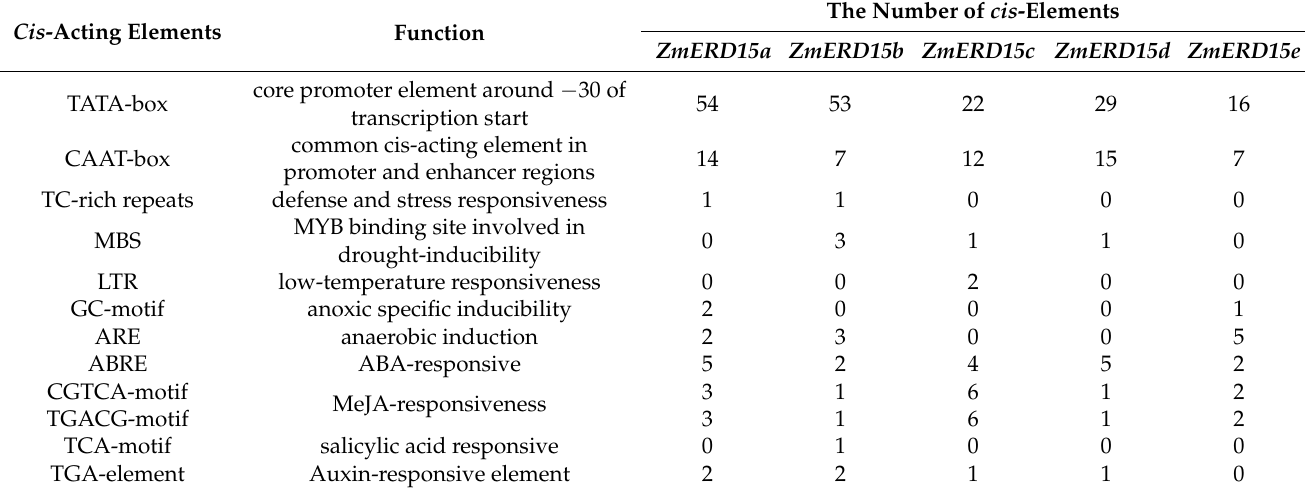
Table 2. The cis -acting elements of ZmERD15s promoter